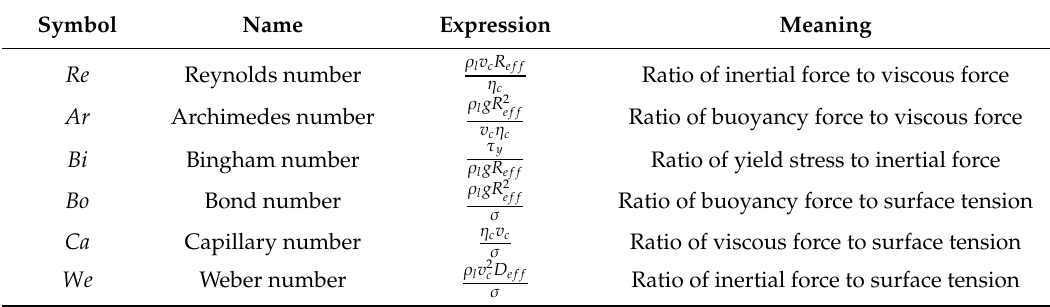
Table 2. List of dimensionless